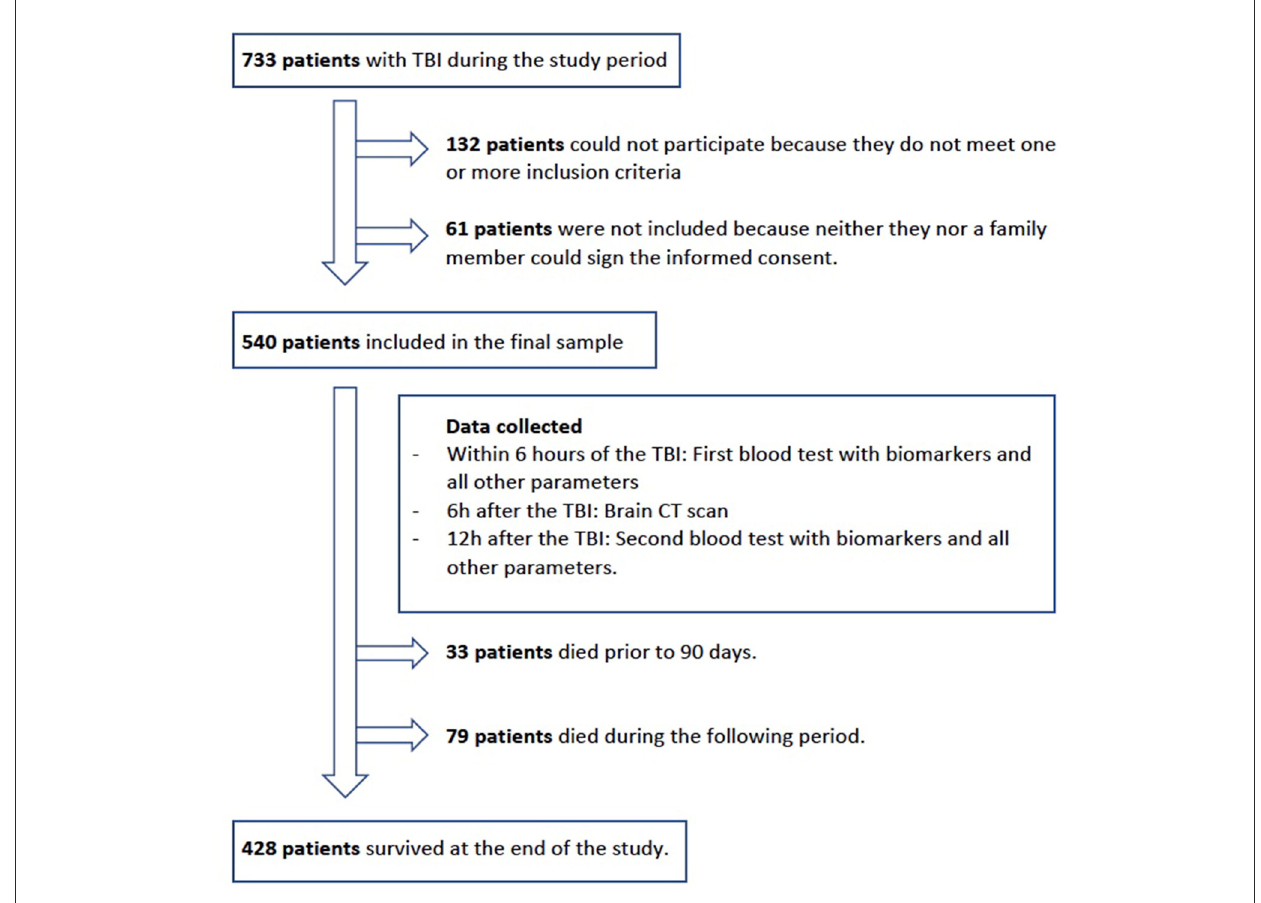
FIGURE1 Flowchart of the patients included in the study.